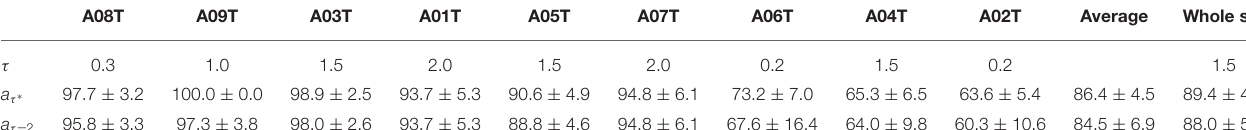
TABLE 2 | The highest accuracy scores performed by each subject by fixing the optimal time window ( τ ∗ ), and across the whole subject set (fixing τ = 2 s).